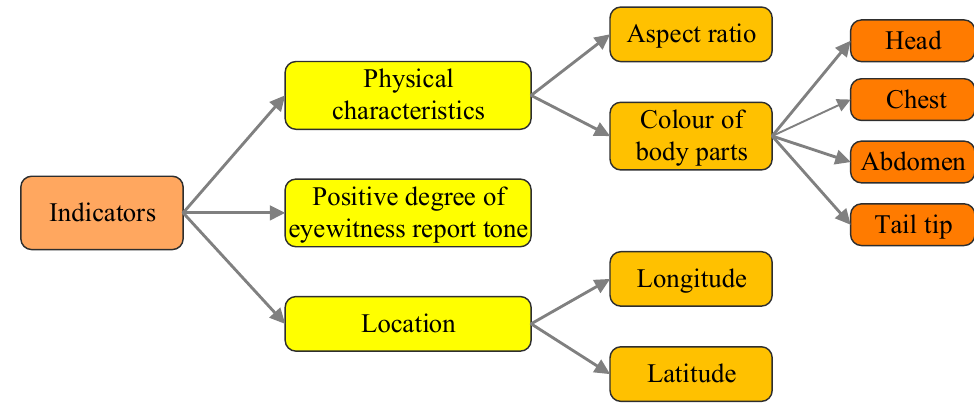
Figure 2. The indicator system of hornet classification.